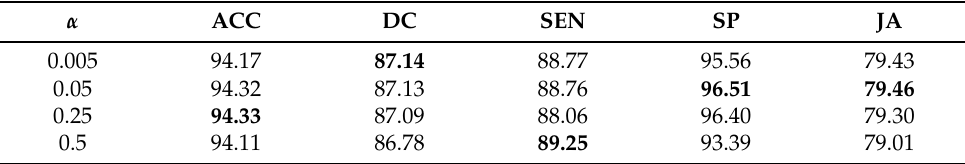
Table 2. Experimental results with different values of α on the test set.